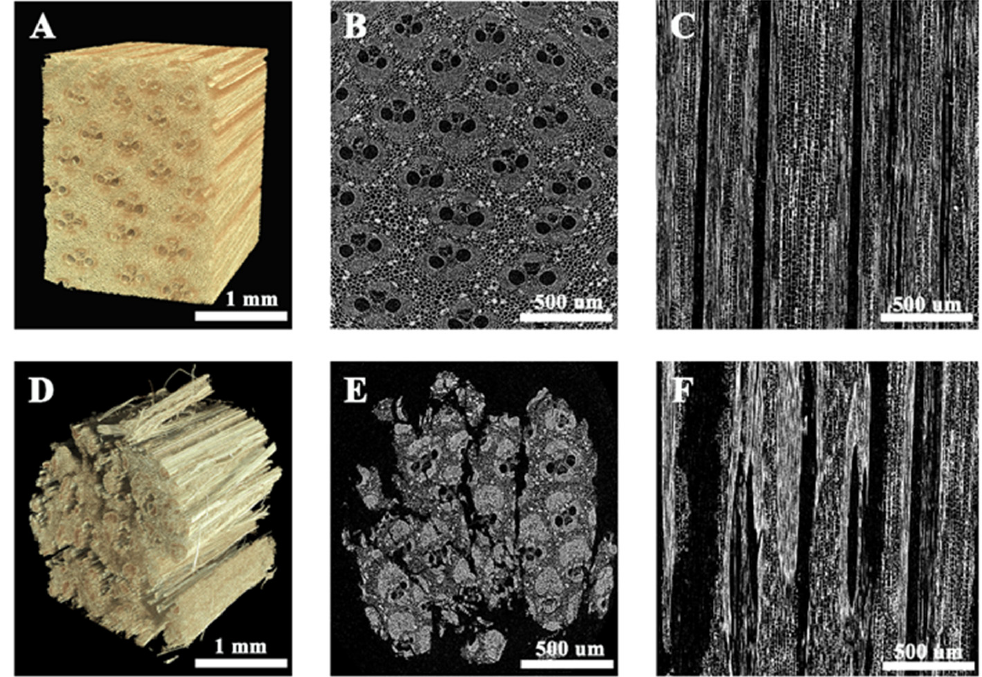
Figure 2. CT images of bamboo and bamboo bundles. ( A , D ) Three-dimensionally reconstructed images; ( B , E ) two-dimensional X-ray tomography slice in the radial direction; ( C , F ) two-dimensional X-ray tomography slice in the longitudinal direction.